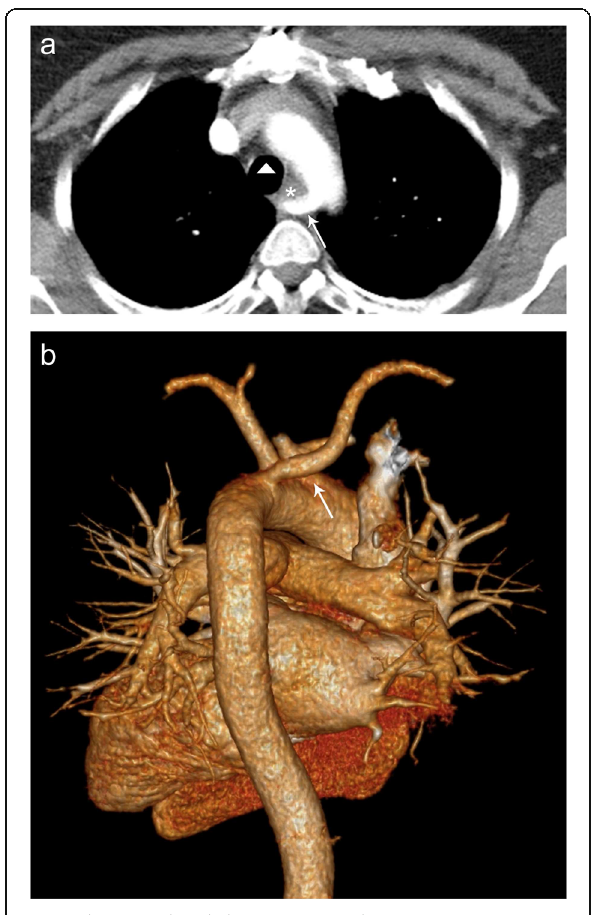
Fig. 5 Aberrant right subclavian artery. Axial ( a ) CT image demonstrating aberrant right subclavian artery (arrow) coursing posterior to the esophagus (asterisk) and trachea (triangle). b 3D model demonstrating the distal take-off the aberrant right subclavian artery (arrow) from the aortic